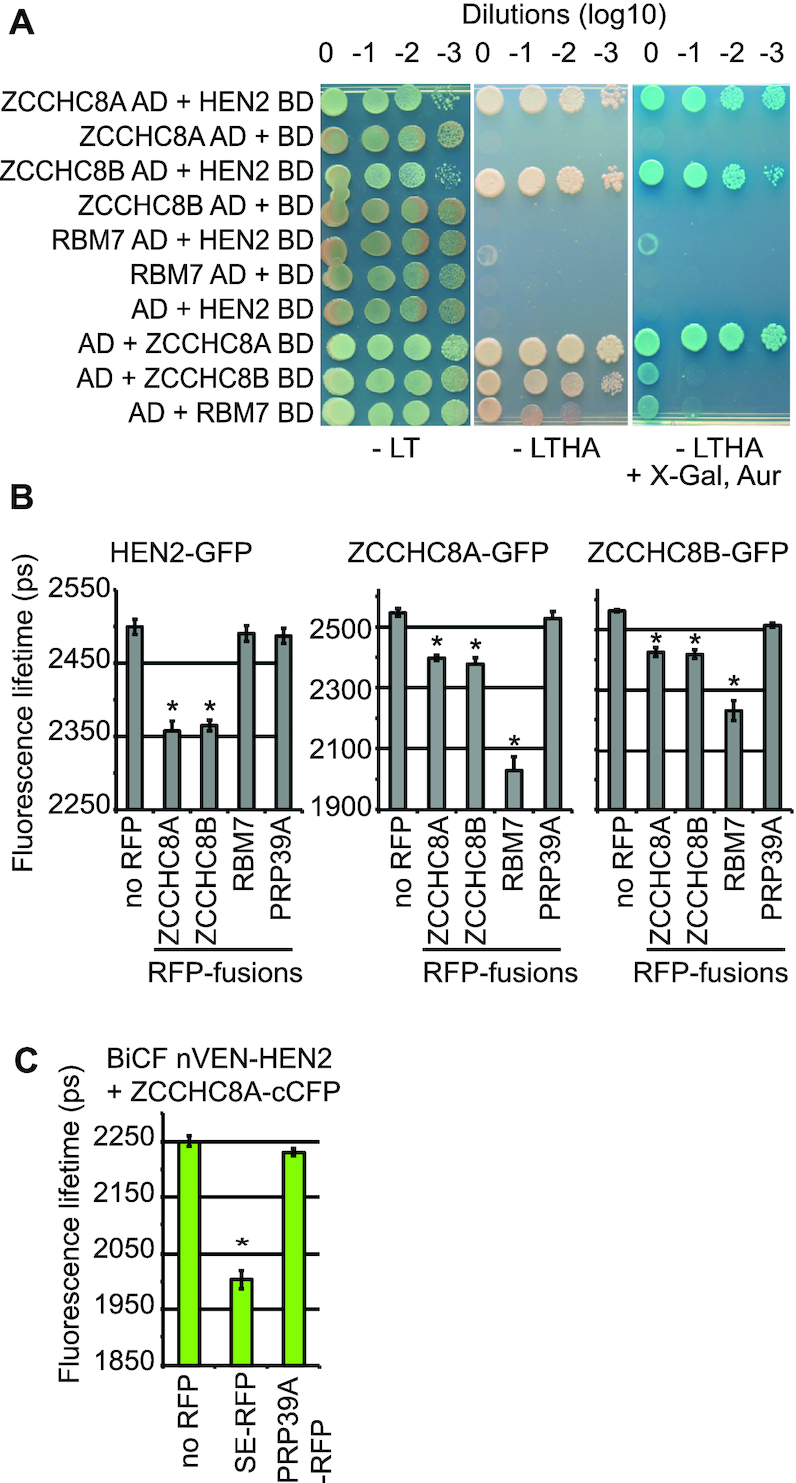
ZCCHC8A and ZCCHC8B interact with both RBM7 and HEN2. (A) Yeast two-hybrid analyses of the interactions between the NEXT subunits. Medium lacking leucine (L) and tryptophan (T) was used to select for pGADKT7 and pGBDKT7 vectors. Interaction was tested on medium lacking also histidine (H) and adenine (A), and by adding aureobasidin (Aur) and the galactosidase substrate X-αGal. The interactions within the NEXT subunits were evaluated using HEN2-BD as the fusion of ZCCHC8A, ZCCHC8B and RBM7 to the BD resulted in autoactivation. (B) FRET-FLIM analyses of protoplasts co-expressing fluorescent fusion proteins. The bar graphs present the fluorescence lifetime of the donor molecules HEN2-GFP (left panel), ZCCHC8A-GFP (middle panel) and ZCCHC8B-GFP (right panel) in picoseconds (ps). The RFP-fusion proteins used as fluorescence acceptors are indicated at the bottom. (C) SE, HEN2 and ZCCHC8A form a trimeric complex. Combined BiFC and FRET-FLIM analysis. The fluorescent donor molecules are produced by the bimolecular interaction of HEN2 and ZCCHC8A fused to the N- and C-terminal fragments of Venus and Cyan fluorescent proteins, respectively. SE and PRP39A were fused to RFP and served as acceptors. The bar graphs present the fluorescence lifetime of the donor molecule produced by BiFC between nVEN-HEN2 and ZCCHC8A-cCFP in picoseconds (ps). Error bars indicate the standard error of the mean, n > 10. The asterisks indicate significant differences (P < 0.001, Mann–Whitney–Wilcoxon test) between the control samples co-expressing the donor fused to GFP and the indicated acceptors fused to RFP to the samples expressing the donor and the PRP39A-RFP control.